Question: In one sentence, what is this figure communicating?
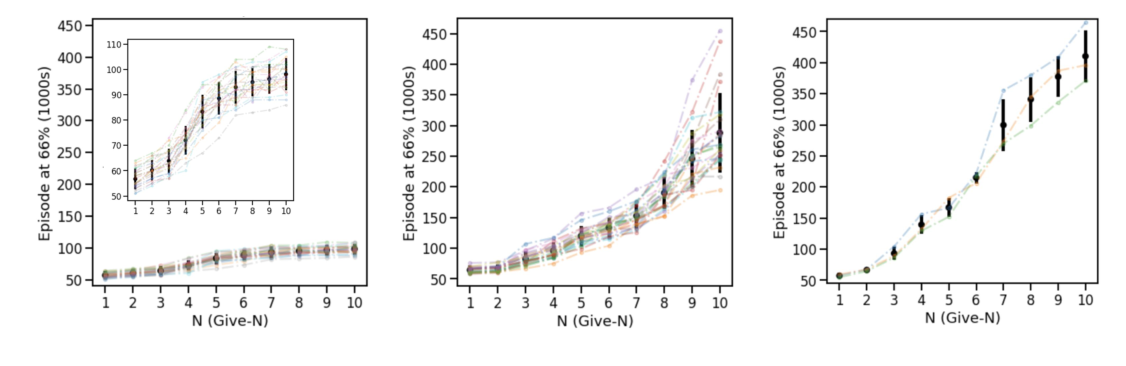
Answer: The relational bottleneck encourages data-efficient and generalizable relation learning. (a) Results for the ESBN and baseline architectures (Transformer, Neural Turing Machine (NTM), Metalearned Neural Memory (MNM), Long Short-Term Memory (LSTM), PrediNet, and the Relation Network (RN)) on the identity rules task, reproduced from [52]. X axis represents the number of potential objects (out of 100 possible objects) withheld during training. When all objects are observed during training (0 withheld), most baselines perform well on the task. When most objects are withheld (95 withheld; test set includes only objects withheld during training), only the ESBN generalizes well to new objects. (b) Results for an object sorting task involving an asymmetric relation (greater-than/less-than), reproduced from [54]. The abstractor learns this task significantly faster than both the transformer and an ablation model in which relational cross-attention is replaced by standard cross-attenti